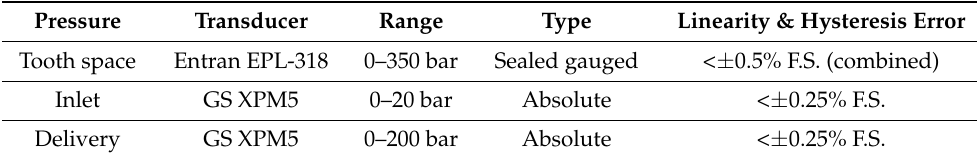
Table 2. Technical data of the pressure transducers mounted directly on the